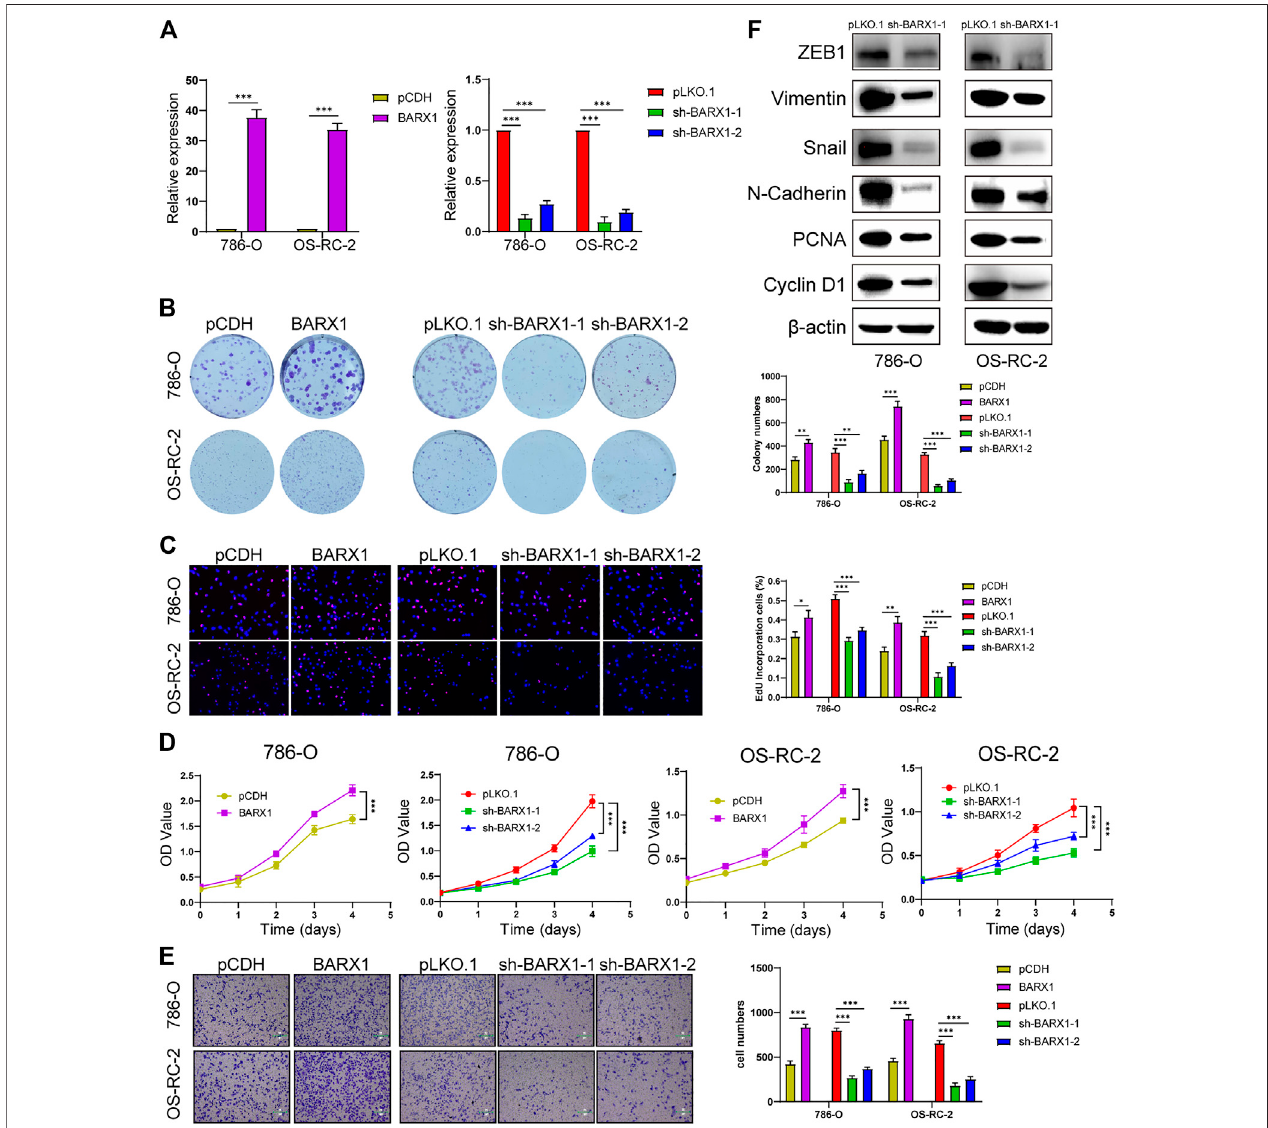
FIGURE6| BARX1promotescellproliferationandmigrationofccRCC. (A) Theef fi ciencyofRCCcelllinesstablyoverexpressingorsilencingBARX1wasvalidated by RT-PCR. (B – D) Colony formation assays, 5-ethynyl-20-deoxyuridine (EdU) assays, and CCK-8 assays were performed in ccRCC cell lines. (E) Transwell migration assay was applied in ccRCC cell lines. (F) The knockdown of BARX1 downregulates the expression of proliferation and EMT-related proteins.